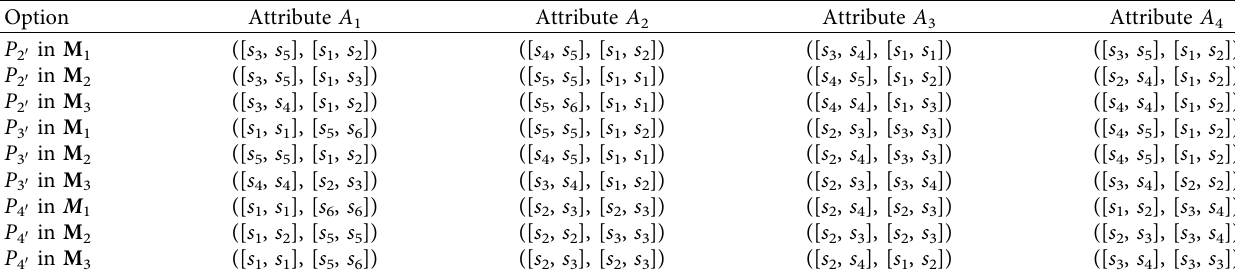
Table 2: The evaluation results of the new worse options.